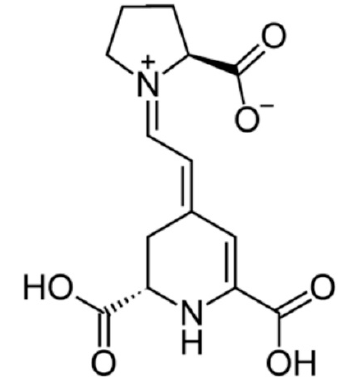
Figure 1. Molecular structure of indicaxanthin.